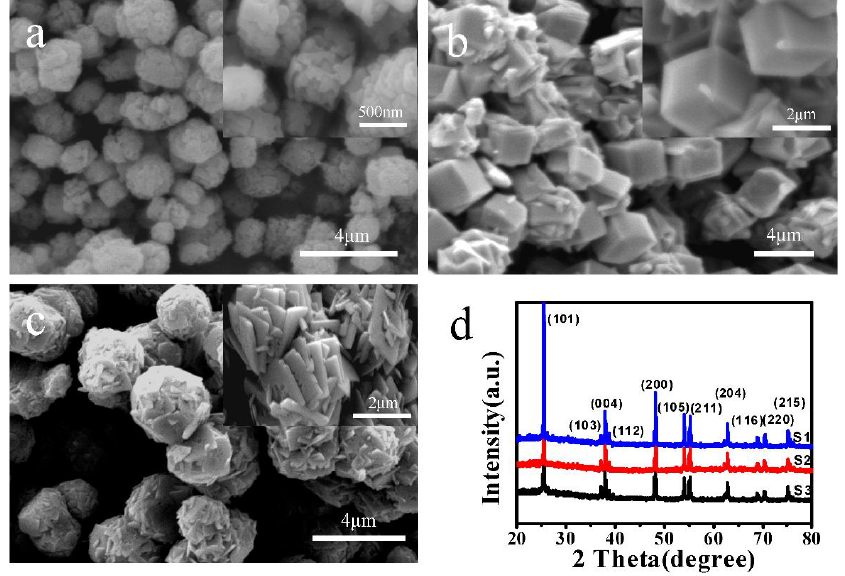
Figure 4. FESEM images of TiO 2 hexahedral and nanosheet structures with different morphologies: ( a ) S1; ( b ) S2 and ( c ) S3; ( d ) XRD patterns of S1, S2, and S3.